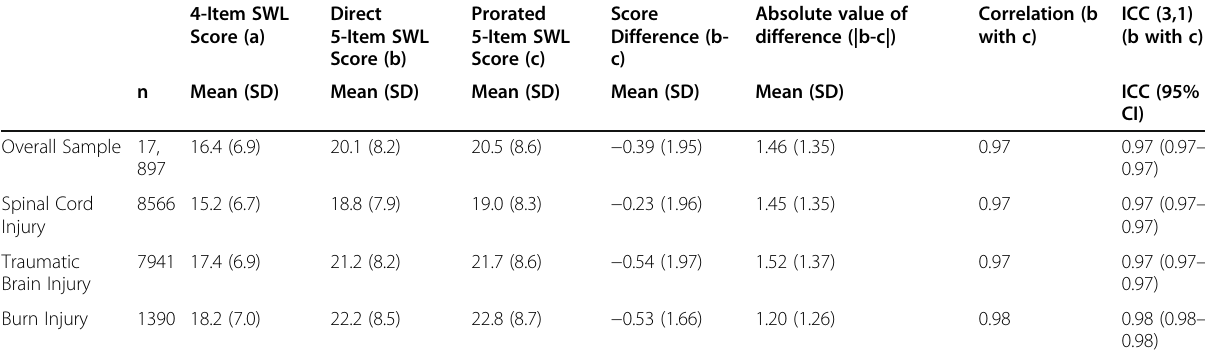
Table 2 Agreement between directly derived and prorated scores of the satisfaction with life scale in the overall sample and within TBI, SCI, and burn injury subsamples